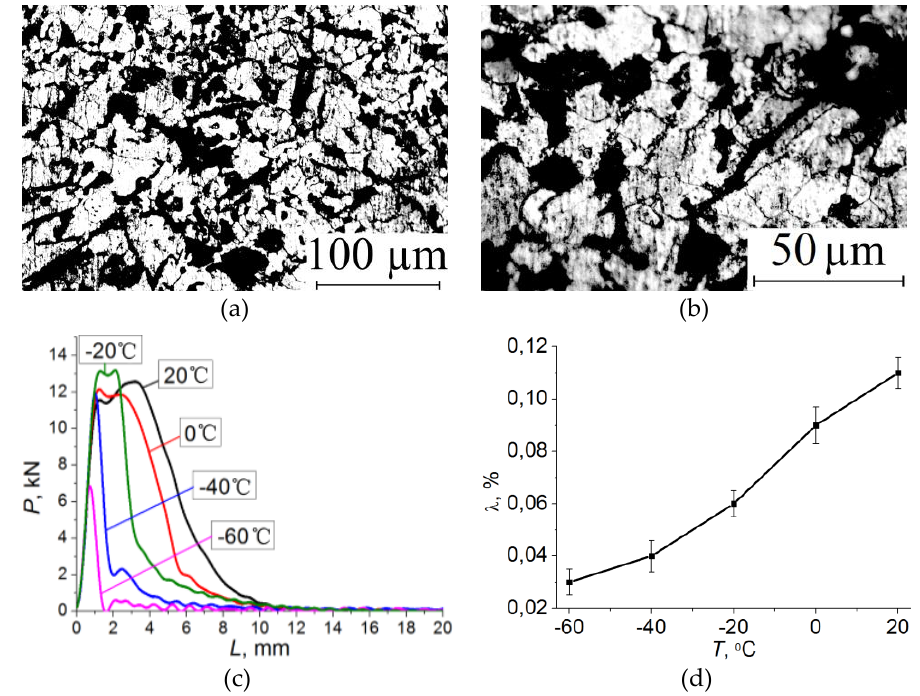
Figure 2. ( a , b ) Optical images of 17Mn1Si steel microstructure in the as-delivered state, ( c ) impact loading curves in the “load–displacement” coordinates for the specimens with the V-notch tested at different temperatures shown in the legend, ( d ) dependence of the maximum contraction ratio of specimens λ (%) in the crack growth region on the test temperature T , °C for specimens with different